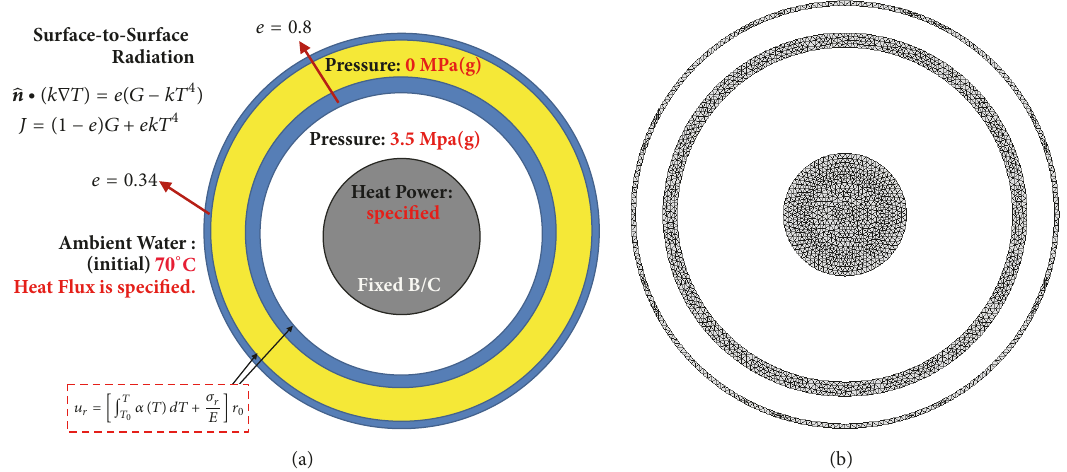
Figure 2: COMSOL computation: (a) boundary condition and (b) grids